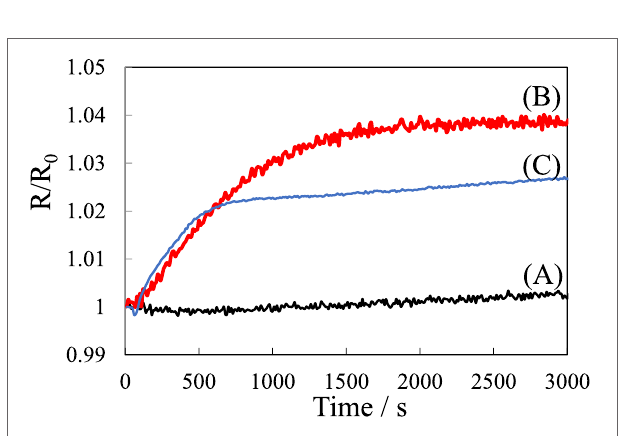
FigUre 2 | X-ray diffraction patterns of C 8 SiGO before and after silylated with (A) (C 1 ) 2 Si, (B) C 1 Si, and (C) APS.